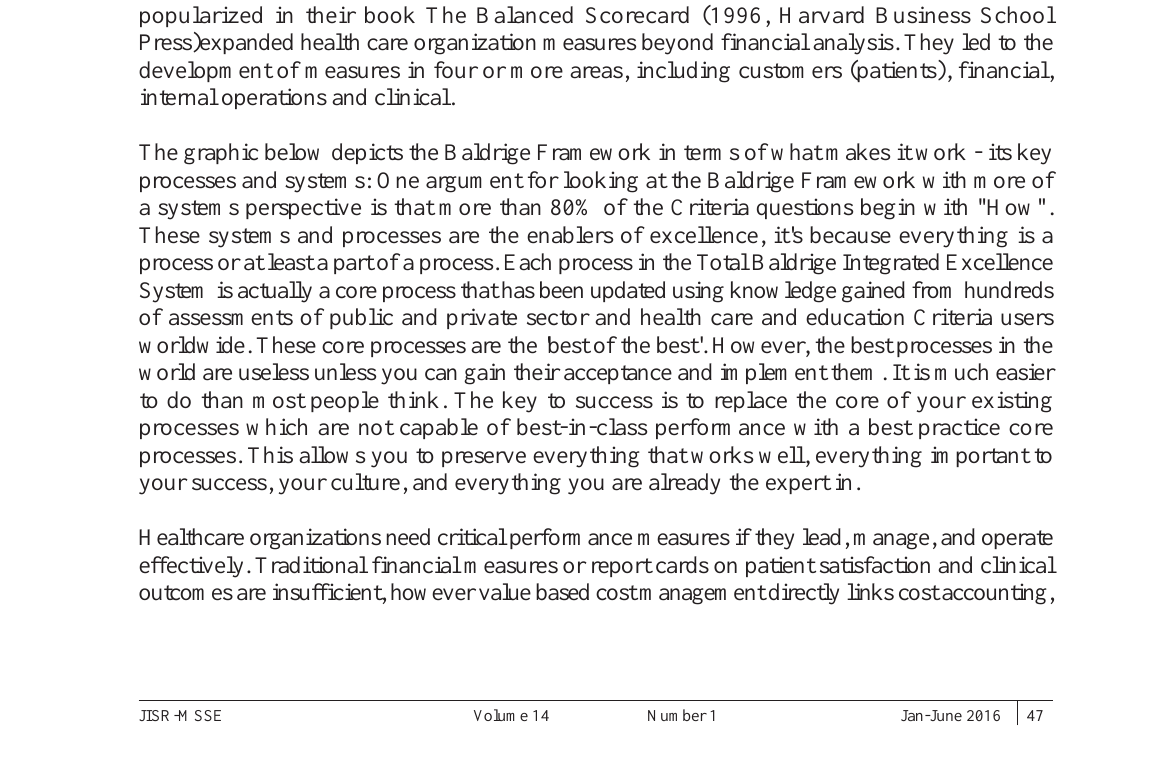
Strategic Planning (A Balance Scorecard)